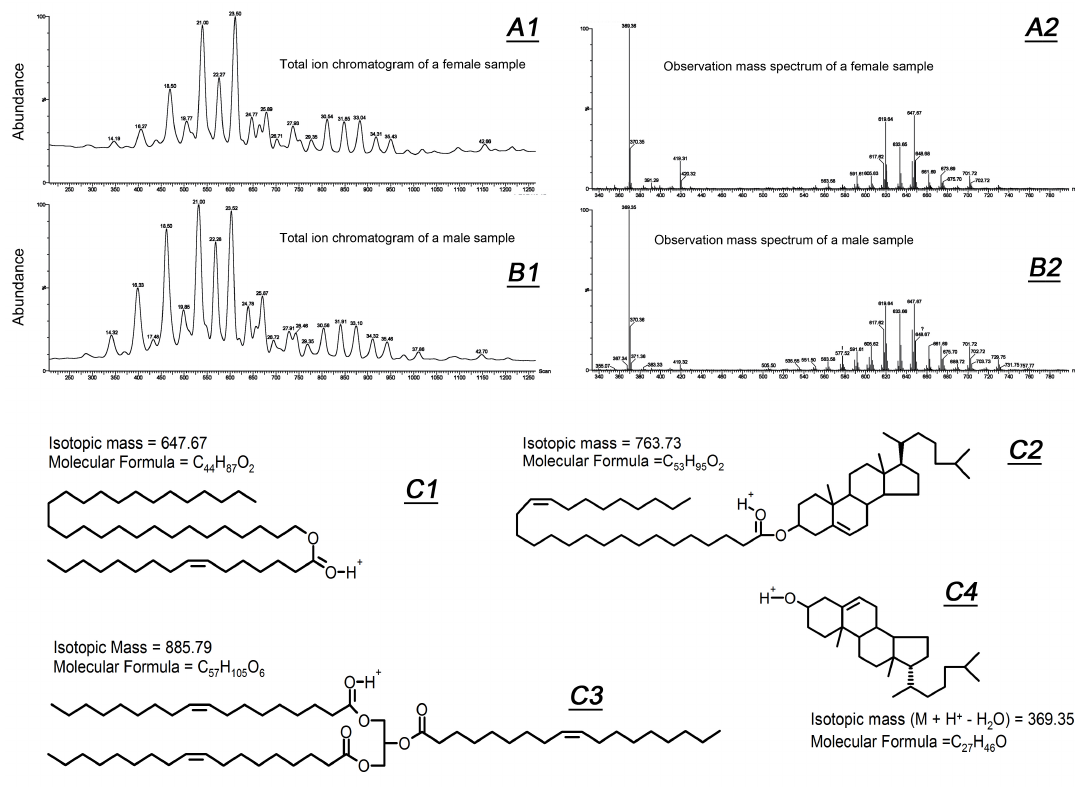
Figure 2. Untargeted lipidomic analysis of female and male meibum samples revealed no major gender-related di ff erences in their chemical composition. ( A1 , A2 ) Total ion RP-UPLC / MS chromatogram of a female meibum sample ( A1 ) and an observation mass spectrum of the sample ( A2 ). Peak with m / z 419.32 is produced by diisononylphthalate (a contaminant / plasticizer commonly present in organic solvents). ( B1 , B2 ) Total ion chromatogram of a male meibum sample ( B1 ) and its observation mass spectrum of ( B2 ). ( C1 – C4 ) Typical representatives of meibomian lipids: Wax ester ( C1 ), cholesteryl ester ( C2 ), triacylglycerol ( C3 ), and free cholesterol ( C4